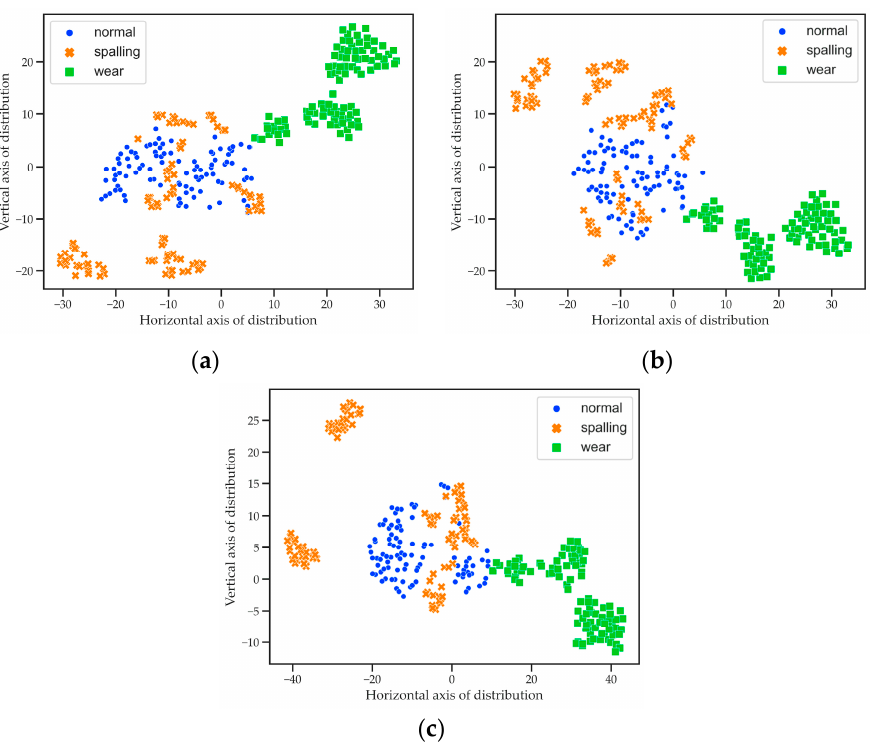
Figure 9. Visualized feature distributions; ( a ) distribution of the frequency-domain datasets; ( b ) distribution of features extracted from the frequency-domain dataset by KPCA; ( c ) distribution of features extracted from the frequency-domain dataset by the SDAE.